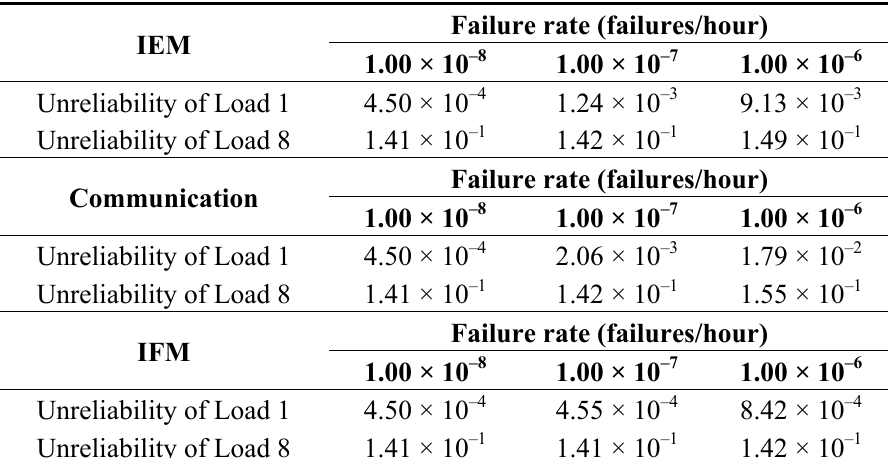
Table 5. Unreliability assessment of selected loads with different failure rate settings for selected